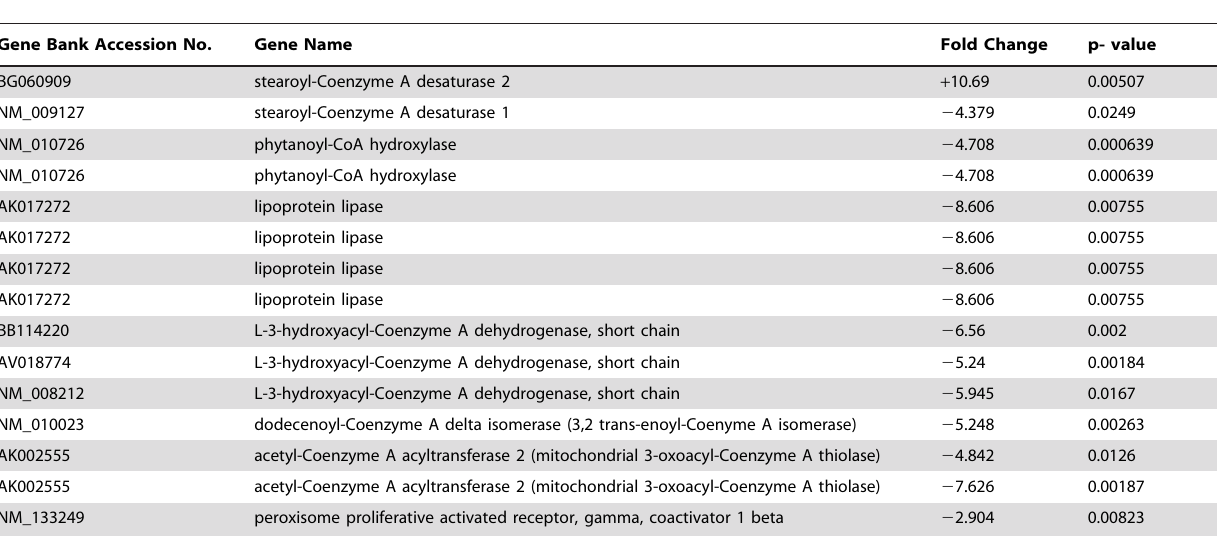
Table 4. Differential expression of genes involved in fatty acid oxidation in mouse skeletal muscle at 4 days 2-AA treatment versus control muscle.